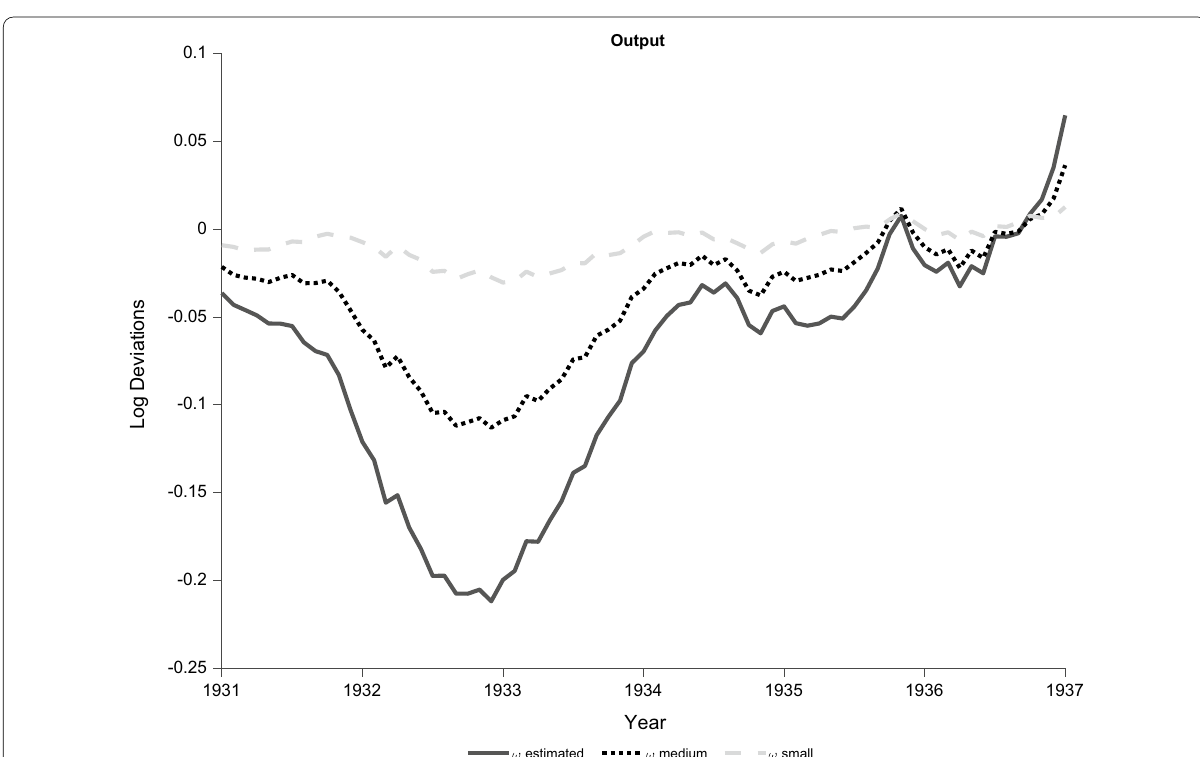
Fig. 6 Counterfactual Price Rigidities. Notes Results are based on 5000 draws from the posterior distribution, median outcomes are reported. Small ω implies an average duration of prices being effective of 50 months, while medium ω implies 100 months. ω estimated implies a median duration of prices of 182